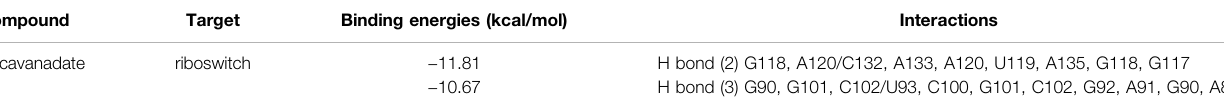
TABLE 5 | Binding energies for best molecular poses of decavanadate in complex with Riboswitch (PDB ID:3DIS). Compound Target Binding energies (kcal/mol) Interactions